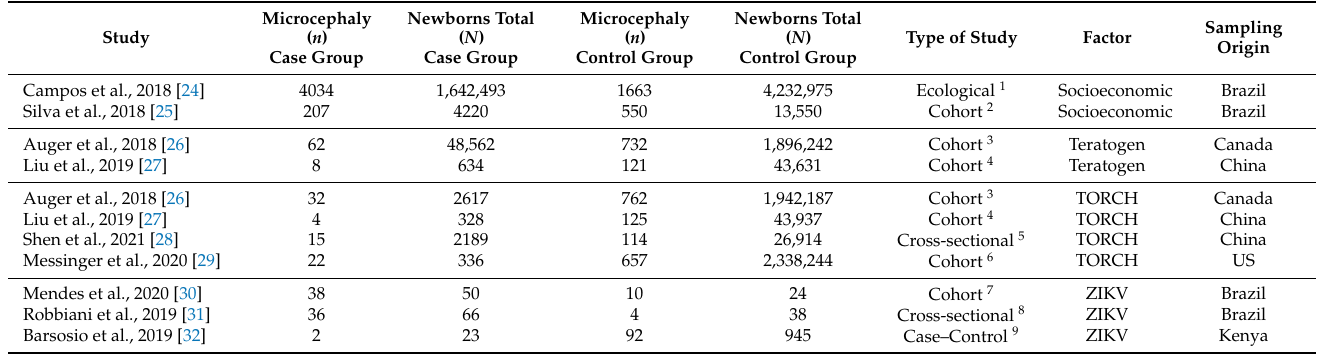
Table 1. Summary of the extracted data from the 9 studies included in